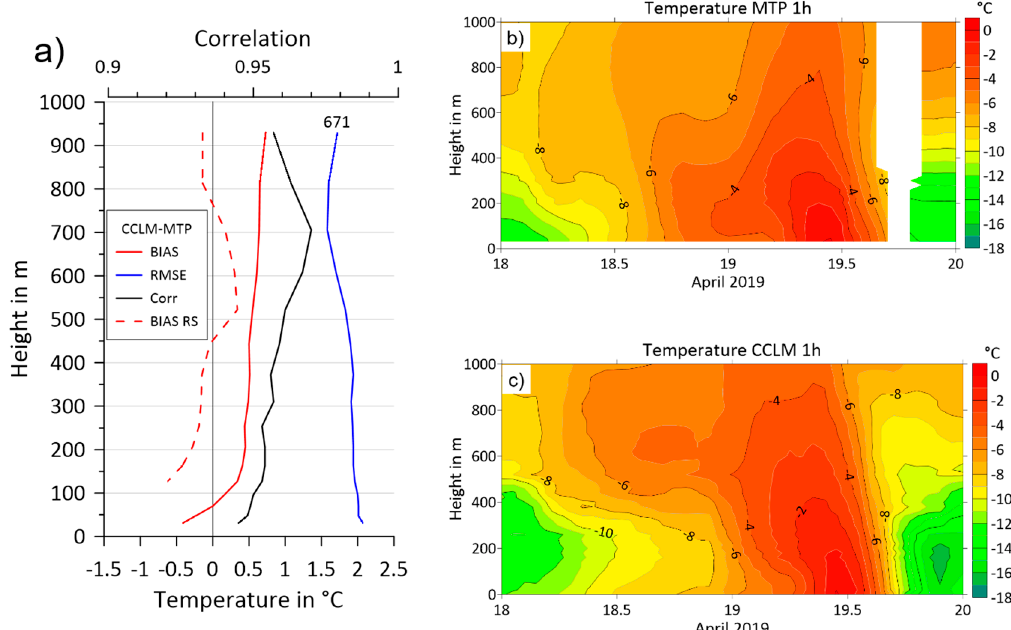
Figure 13. Comparisons of CCLM with 1h temperature data of the MTP5 profiler. ( a ) Profiles of bias, RMSE and correlation for 1–29 April 2019 (671 profiles), the profile of the bias CCLM compared to radiosondes is shown as a dashed line. Time–height cross-sections for the temperature for 18–20 April 2019 for CCLM ( b ) and ( c ) for the MTP5 profiler.